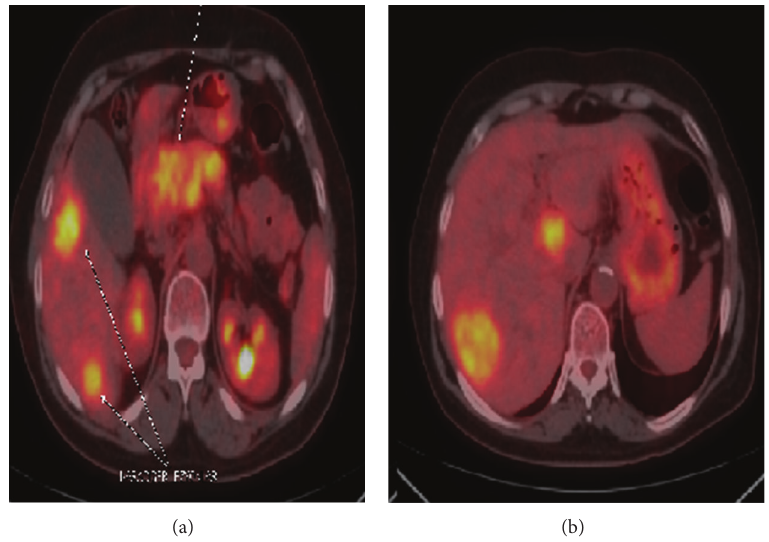
Figure 3: Intense involvement of Yttrium-90 in pancreas and hepatic metastases.